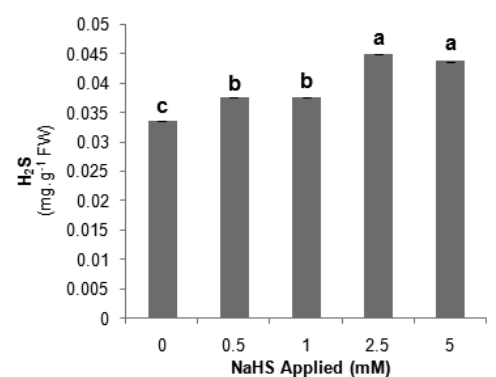
Fig. 2: Effects of different doses of NaHS on H 2 S shoot concentration. Columns are mean ± S.E. ( n = 9 ). Different letters indicate significant difference between values.